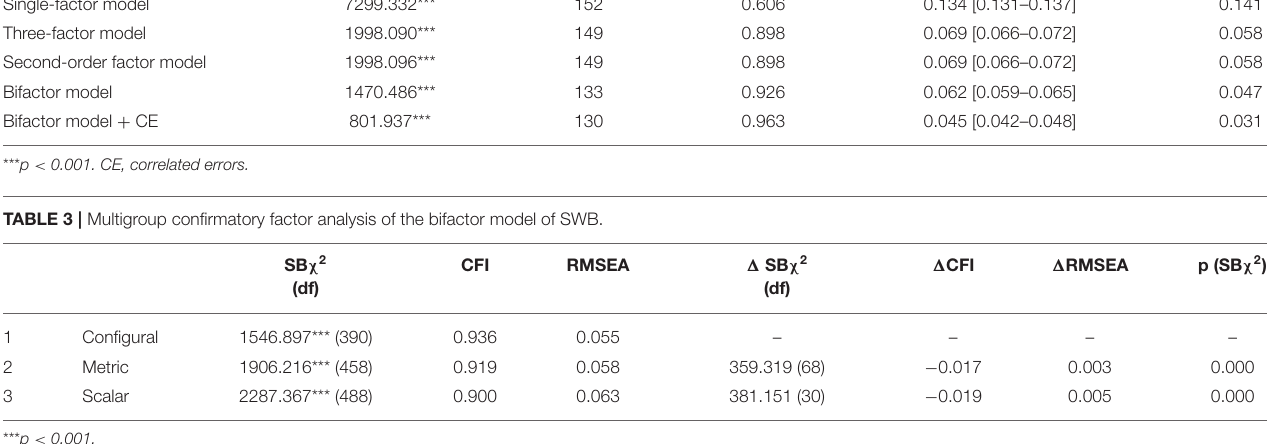
TABLE 4 | Standardized factor loadings, construct reliability, and sources of variance for the bifactor model of SWB. Total